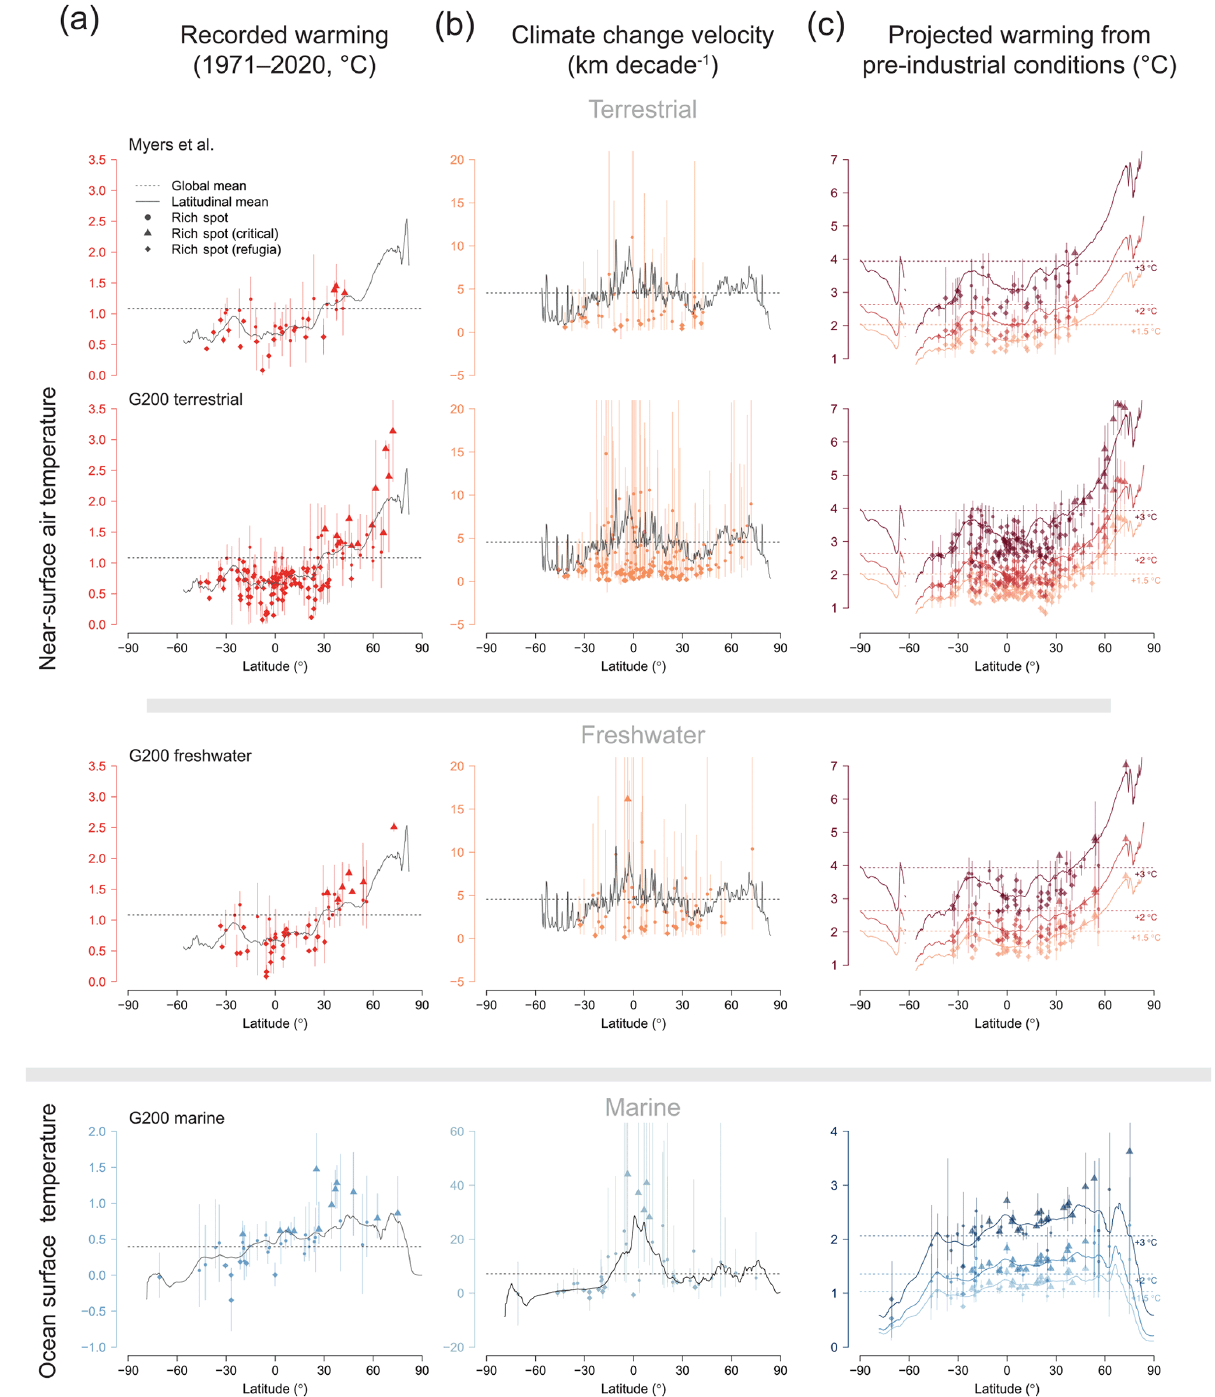
Figure 4. Latitudinal patterns of global warming in individual rich spots. (a) Recorded absolute changes between the average annual means in the 1971–1980 interval and the 2011–2020 interval, (b) climate change velocities in the same interval, (c) projected warming compared to pre-industrial conditions when warming reaches the + 1.5, + 2, and + 3 ◦ C levels (averaged across multiple scenarios). Dashed lines indicate global means (only land or ocean, respectively), and solid curves indicate the latitudinal means. Vertical bars denote the interval between percentiles 2.5 and 97.5 of values within one rich spot. Triangles indicate rich spots that are critically warming compared to the global mean, and diamonds indicate global refugia. See Table 1 for the tabulation of refugia and critically warming rich